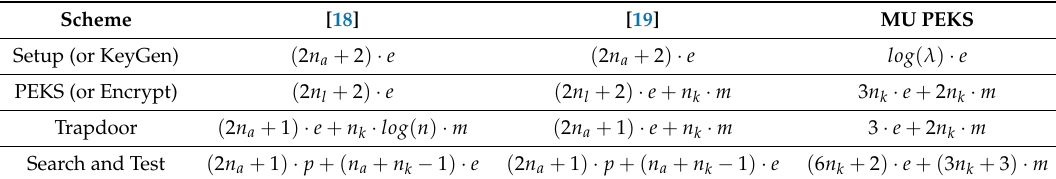
Table 4. The comparison of computation complexity.